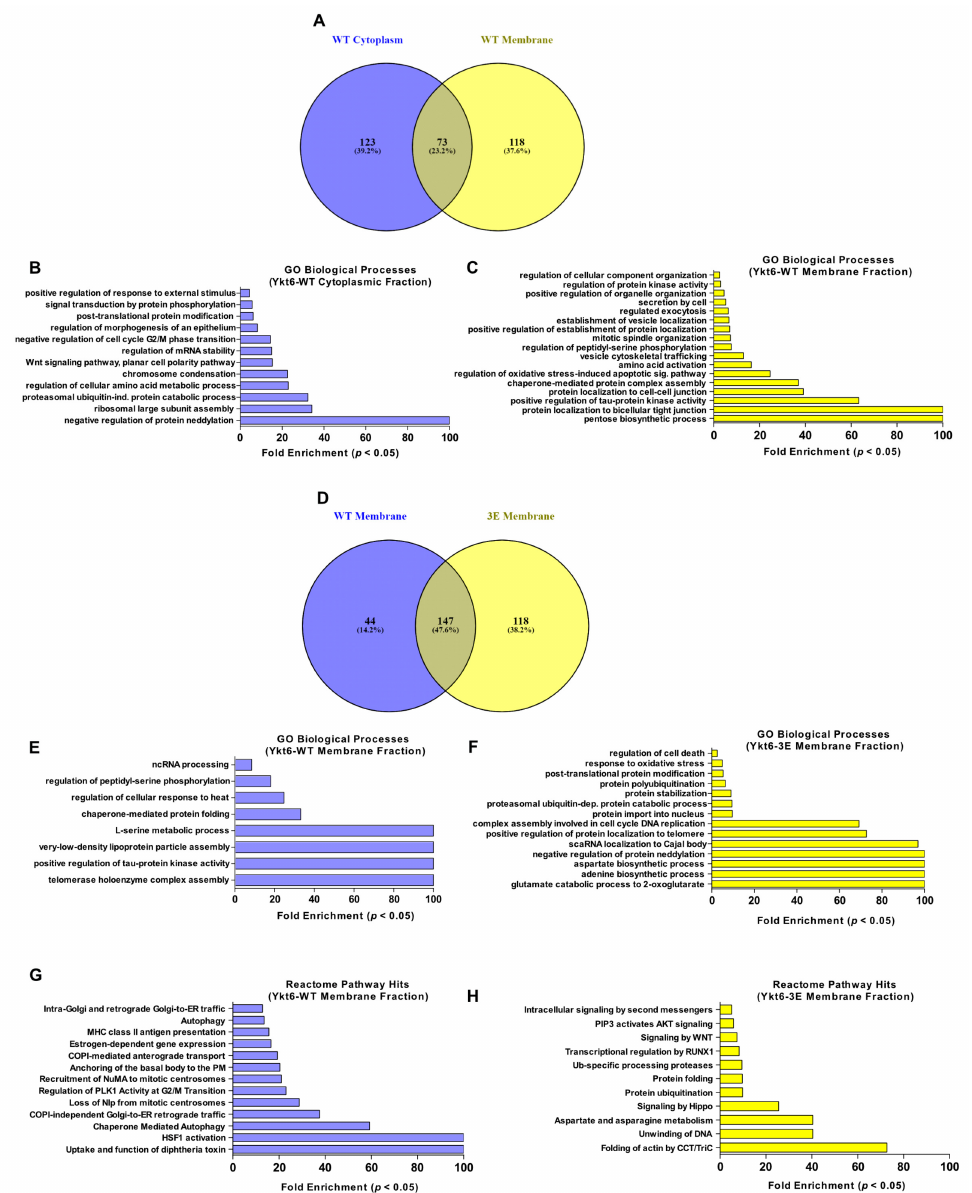
Figure 4. Ykt6 SNARE-dependent proximity proteome. ( A ) Proteins enriched in Ykt6-WT cytoplasmic fraction versus membrane fraction. ( B , C ) Enriched GO biological processes of Ykt6-WT in cytoplasmic versus membrane fraction. ( D ) Proteins up-regulated between Ykt6-WT versus Ykt6-3E in the membrane fraction. ( E , F ) Enriched GO biological processes of Ykt6-WT and -3E with a ( p -value < 0.05) as determined by Fisher Exact Test with the Benjamini–Hochberg False Discovery Rate < 0.05. ( G , H ) Enriched Reactome Pathway hits of Ykt6-WT and -3E in the membrane fraction based on FDR <